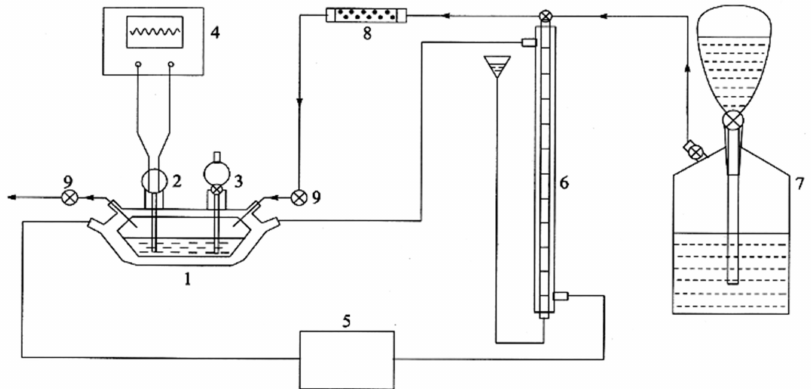
Figure 1. Laboratory installation for oxidation of phenol with oxygen: 1, reactor; 2, electrode; 3, unnel for reagent input; 4, potentiometer; 5, thermostat; 6, measuring burette; 7, gasometer; 8, transition valve; 9,